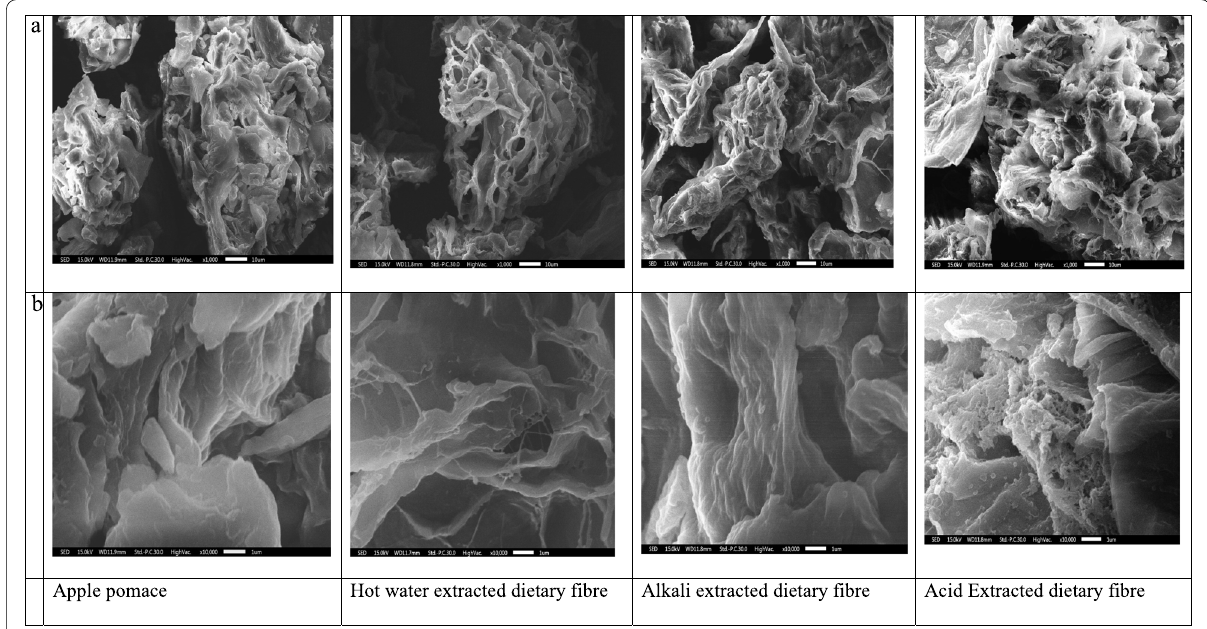
Fig. 1 Micrographs of apple pomace extracted through different methods as determined by SEM at different